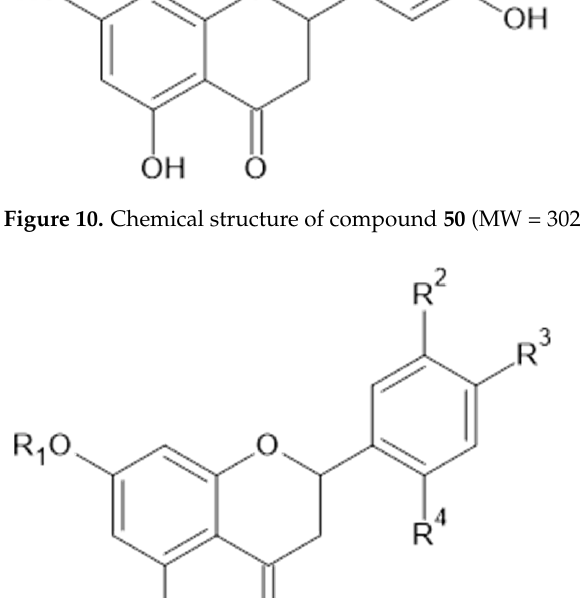
Table 5 . Apigenin and derivatives.